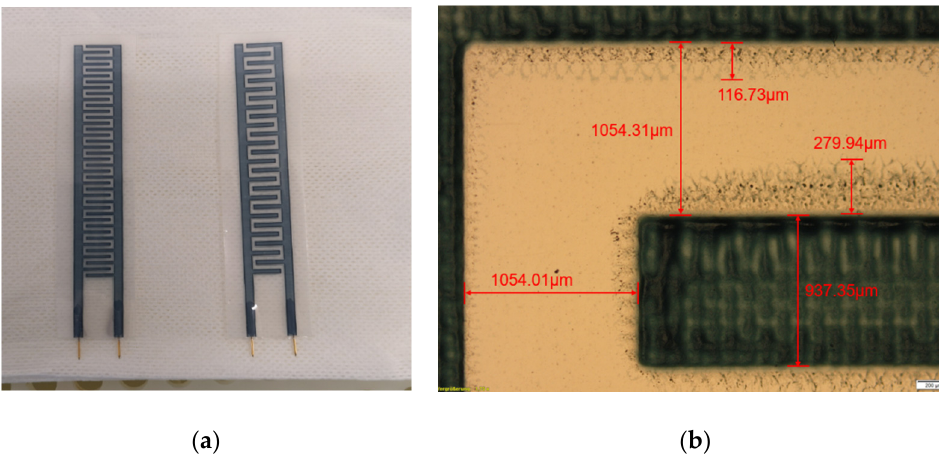
Figure 10. ( a ) Printed samples of PEDOT:PSS capacitive sensors; ( b ) photo image of 1-mm electrode sensor.